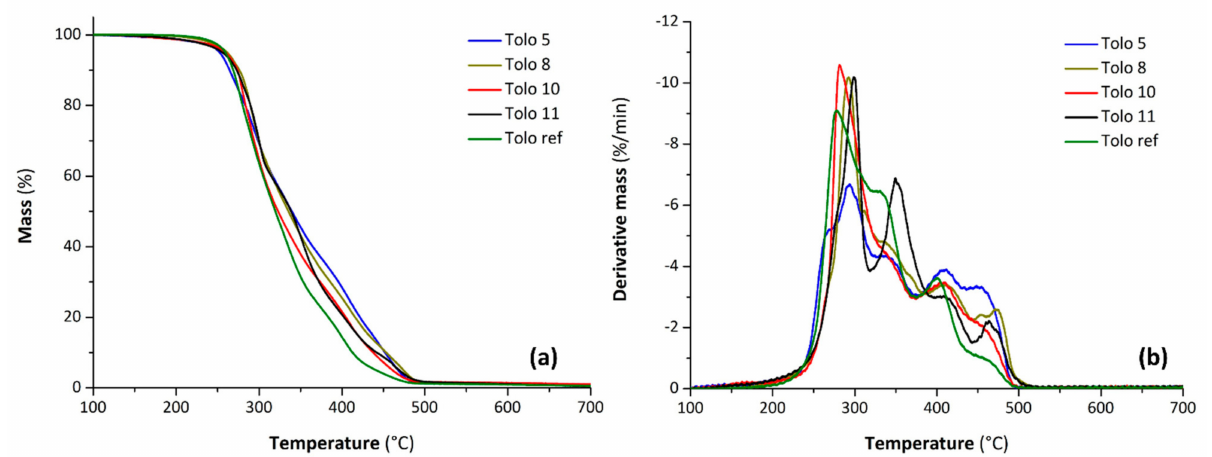
Figure 11. Thermogravimetric analysis ( a ) and derivate thermogravimetry ( b ) curves of PU